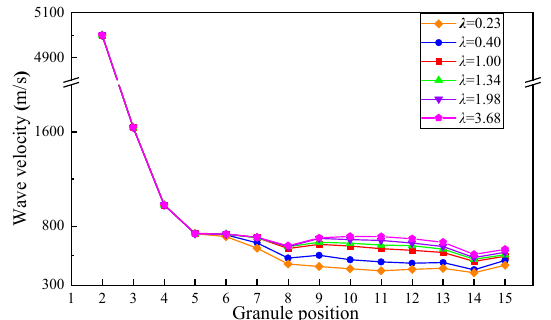
Figure 11. Wave velocity in the whole granular chain.